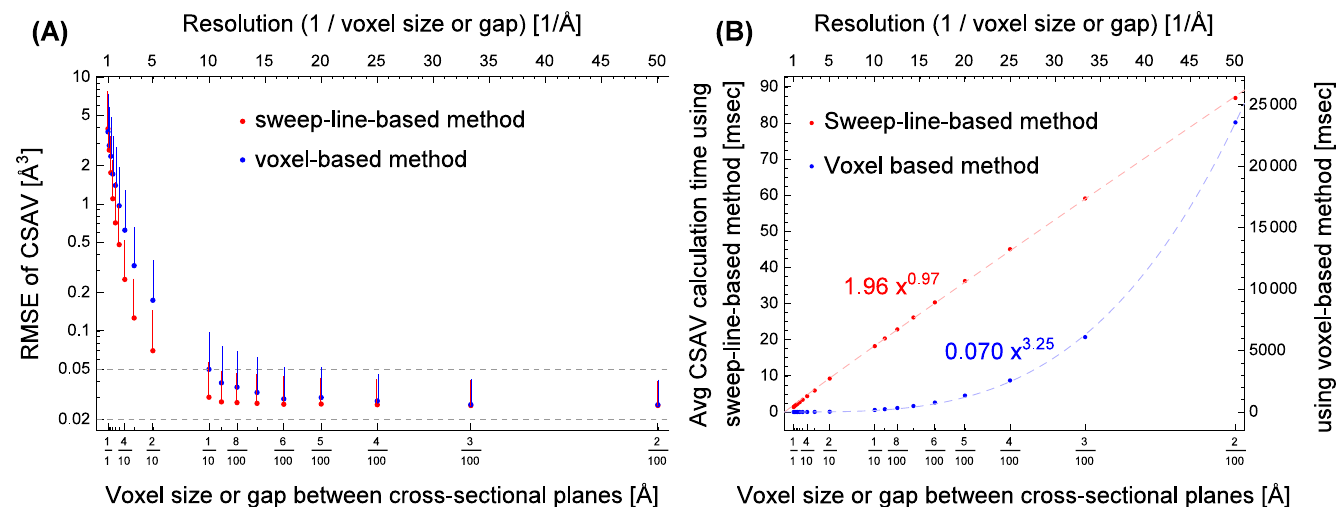
Fig 9. The comparison of (A) the root mean square error and (B) the computational cost in different resolutions determined using the sweep-line-based method (red) and the voxel-based method (blue).